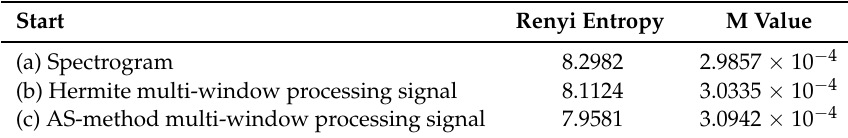
Table 1. The motion signal processing results of Renyi entropy and M value.